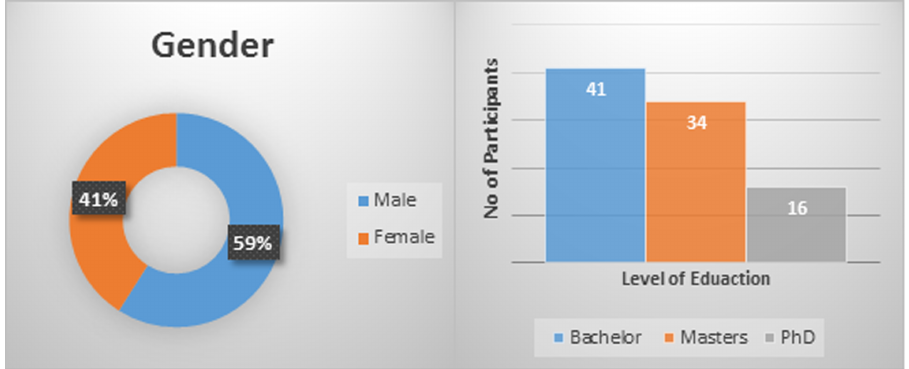
Figure 12. Gender and Level of Education Charts.